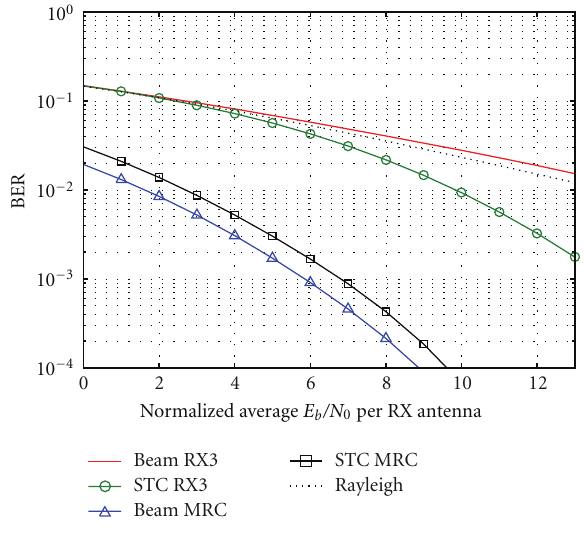
Figure 12: BER as a function of the normalized received E b /N 0 per antenna, for communication via a single dominant specular reflection and transmissions at equal total E b ,tr .